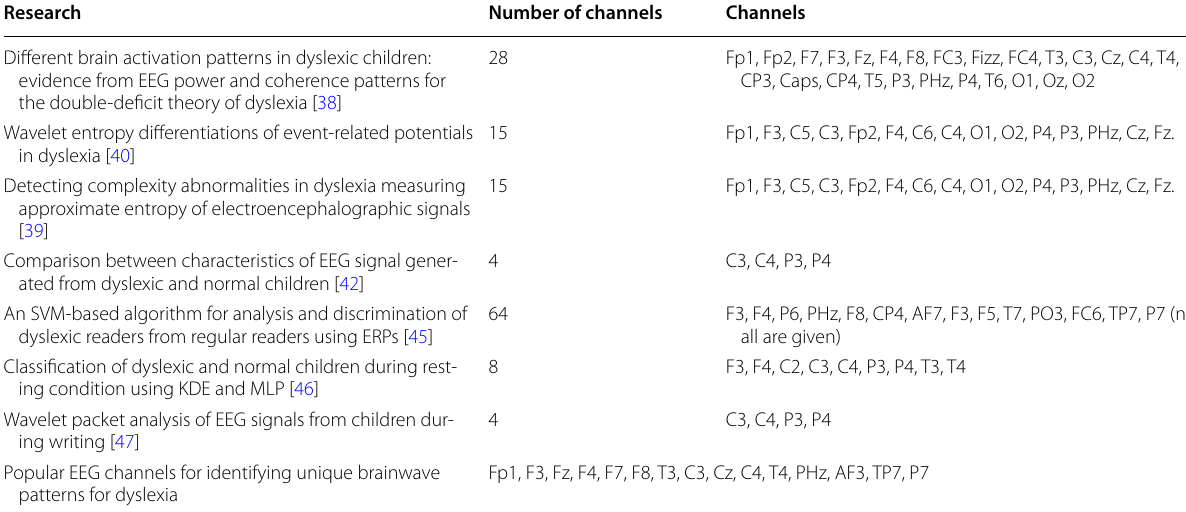
Table 6 Popular choice of EEG channels